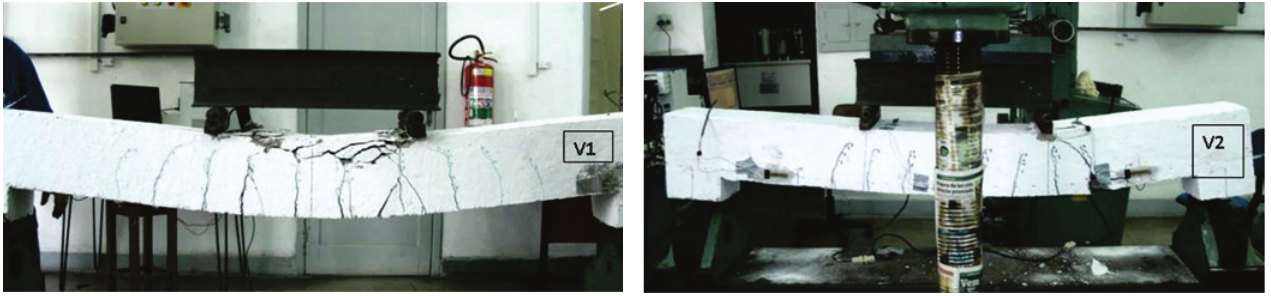
Cracking mode and type of failure of the beams V1 e